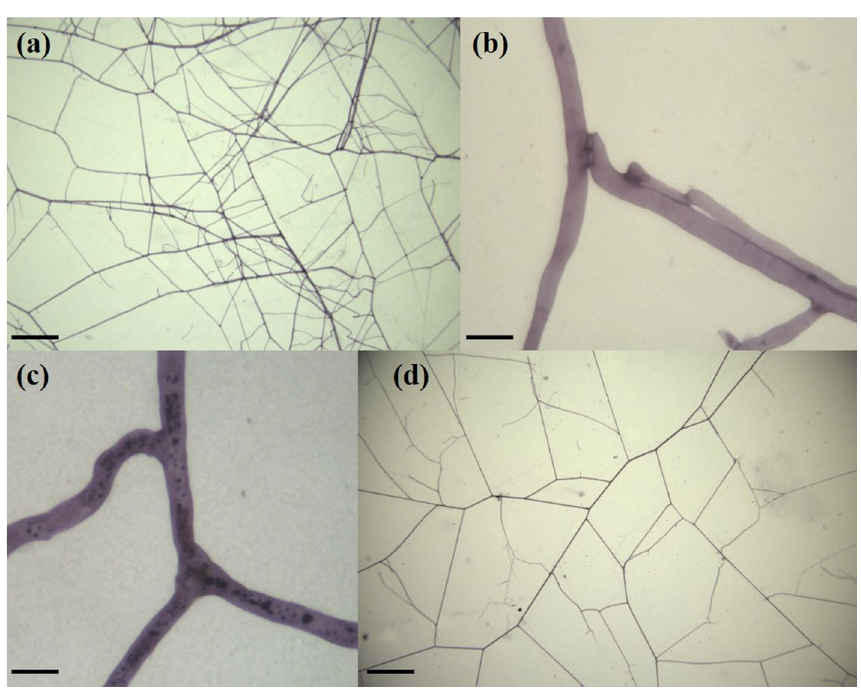
Figure 5. Membranes bearing Rhizoglomus irregulare IMA6 extraradical mycelium (ERM) produced in symbiosis with Zea mays , after Trypan blue staining (a, b, d) or succinate dehydrogenase (SDH) activity localization ( c ). ( a ) Highly interconnected ERM produced in symbiosis with maize line B73, scale bar = 160 μm; ( b ) multiple hyphal anastomoses in ERM growing from B73 roots, scale bar = 17 μm; ( c ) SDH-positive (viable) hyphal anastomoses, indicated by the deposition of blue formazan salts, in ERM produced in symbiosis with maize line Mo17, scale bar = 12.5 μm; ( d ) ERM growing from roots of the maize line Mo17, scale bar = 170